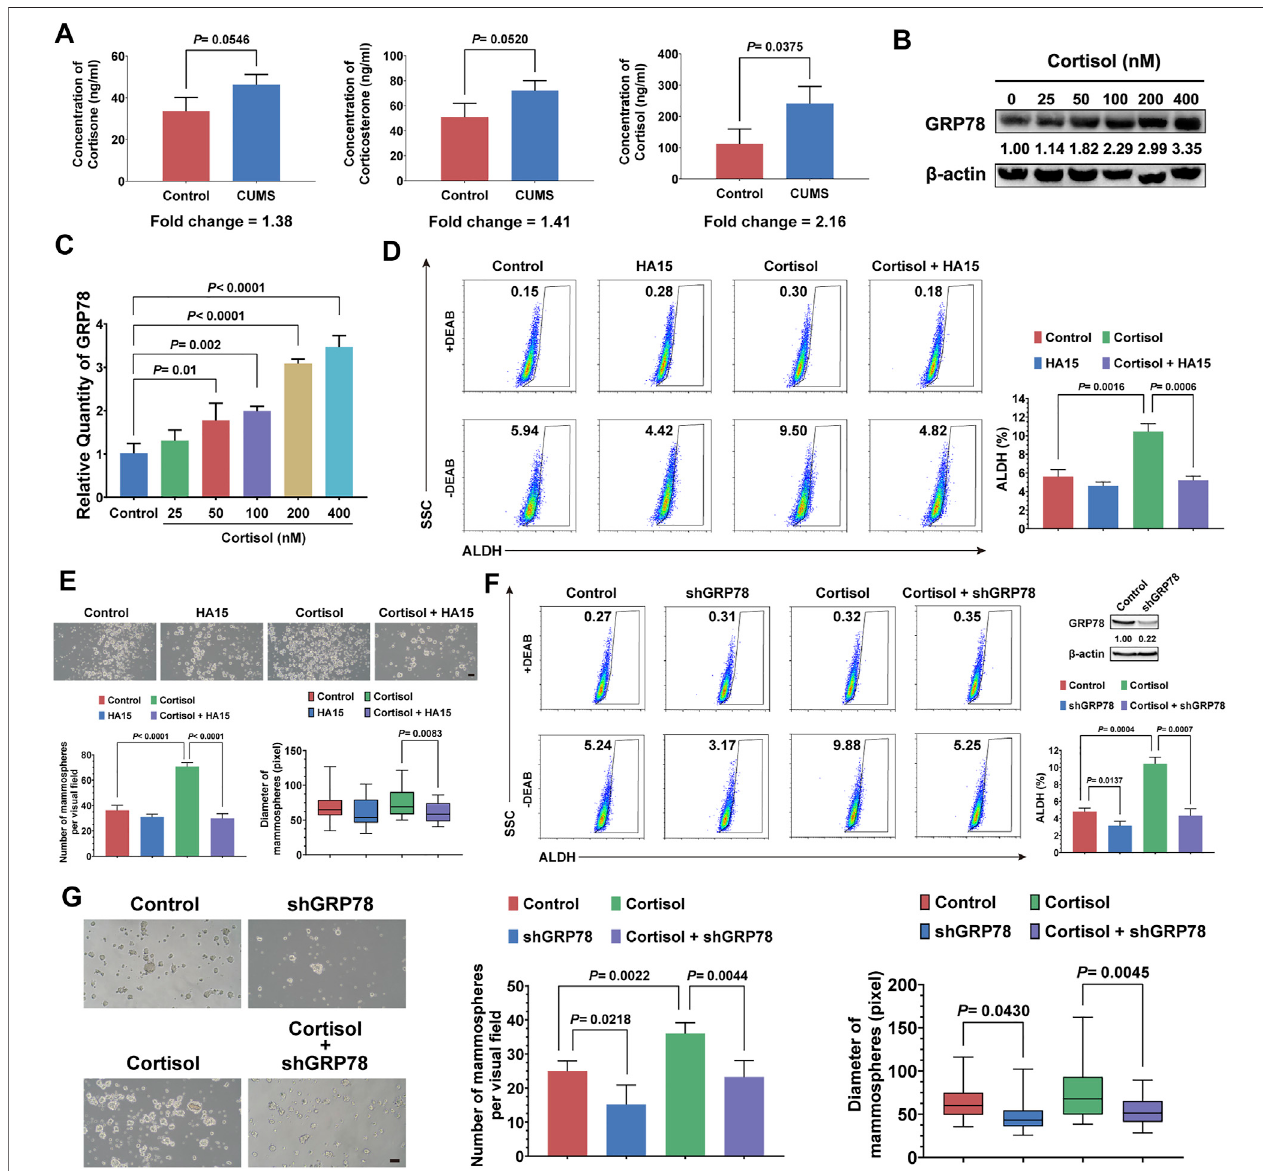
FIGURE4| Cortisolelevated byCUMSenhancesthestemnessofbreastcancercellsviaGRP78. (A) Therelativelevelsofcortisol,corticosterone,andcortisone in theplasmaofthemiceexposedtoCUMS weremeasuredbyELISAs. (B) GRP78 expression in4T1cellswasdetected bywesternblotsaftertreatmentwithcortisolata gradient concentration for 24 h. (C) The 4T1 cells were treated with cortisol at a gradient concentration for 24 h, and the relative mRNA expression of GRP78 was quanti fi ed by qPCR. (D) The ALDH + cell population induced by cortisol was analyzed in the 4T1 cells after treatment with HA15 (10 μ M), an inhibitor of GRP78, for 24 h. (E) The effect of HA15 on the size and number of the mammospheres induced by cortisol was quanti fi ed (the scale bars indicate 100 μ m). (F) The ALDH + cell population induced by cortisol was analyzed by fl ow cytometry following the GRP78 knockdown with shRNA (veri fi cation by western blot in the upper right panel). (G) The effects of GRP78 knockdown by shRNA on the size and number of the mammospheres induced by cortisol were examined (the scale bars indicate 100 μ m). Data arerepresentedasthemeanvalue ± SD.Onerepresentativeexperimentofthreeindependentexperimentsisdisplayed.Unpairedtwo-sidedStudent ’ st-tests(A,D,E,F, G), one-way ANOVA, and Dunnett t-tests as post hoc tests (C) were